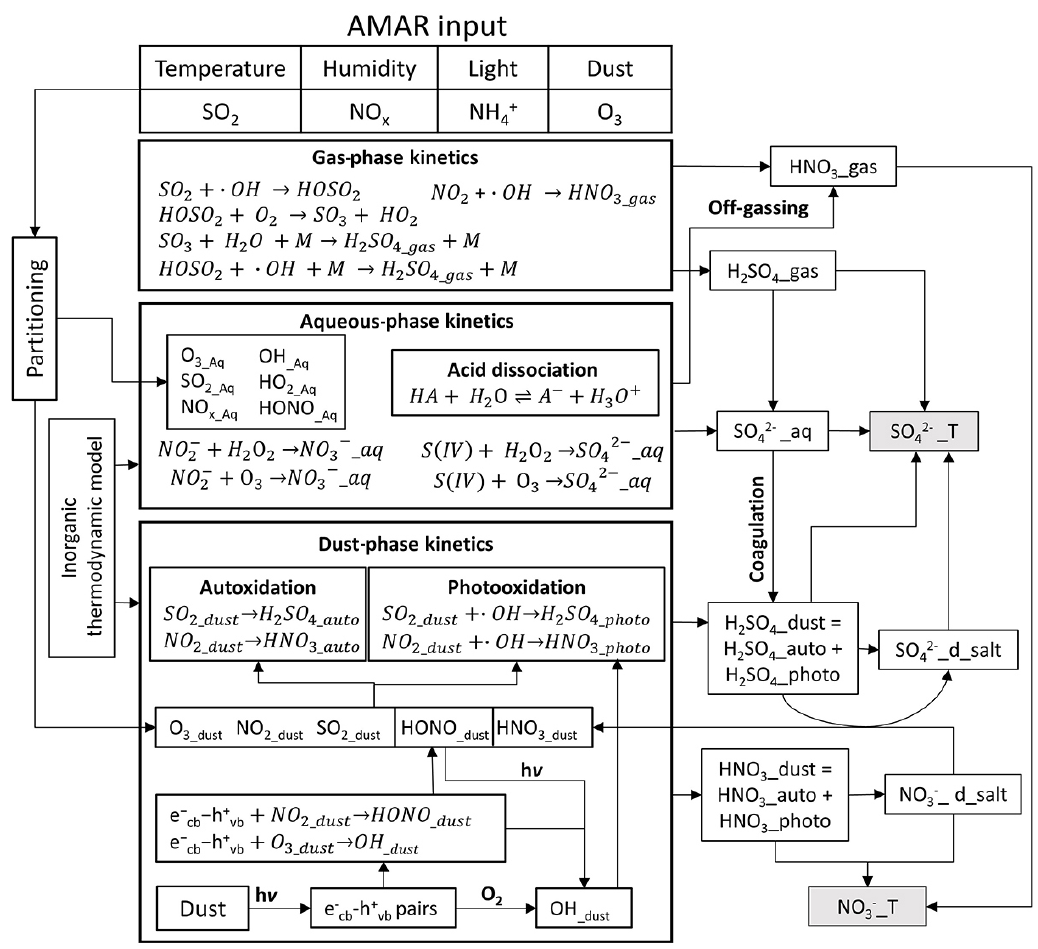
Figure 1. The overall schematic of the AMAR model to simulate heterogeneous SO 2 oxidation. For the description of chemical species, gas phase, aqueous phase, and dust phase are symbolized as “gas”, “aq”, and “dust”, respectively. SO 2 − H 2 SO 4 _dust are the total sulfate formation and the formation of sulfate from gas phase, aqueous phase, and dust phase, respectively. SO 2 − _d_salt and NO − _d_salt are the neutralized sulfate and nitrate in the dust 4 3